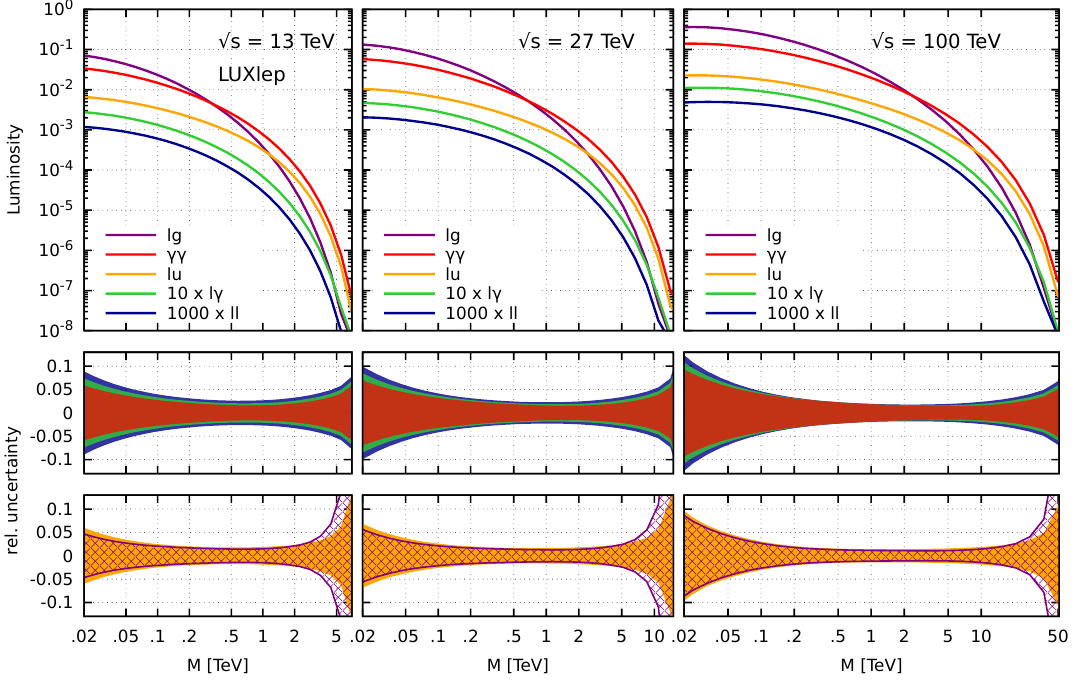
Figure 7. The lepton-gluon ( lg , purple), photon-photon ( (cid:13)(cid:13) , red), lepton-up ( lu , orange), lepton- photon ( l(cid:13) , green), and lepton-lepton ( ll , blue) luminosities at 13 TeV (left), 27 TeV (center) and 100 TeV (right) in pp collisions (as de(cid:12)ned in the text) in the case of the electron, computed using the LUXlep set. Di(cid:11)erences with respect to the muon or tau case cannot be appreciated on the scale of the